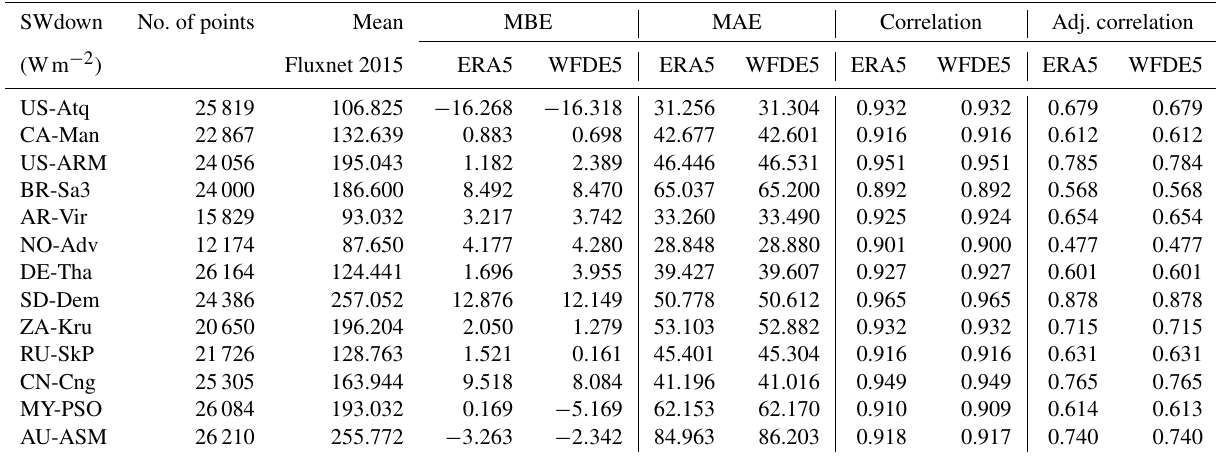
Table A5. SWdown metrics for each FLUXNET2015 site: ERA5 versus FN2015 and WFDE5 versus FN2015 at hourly time